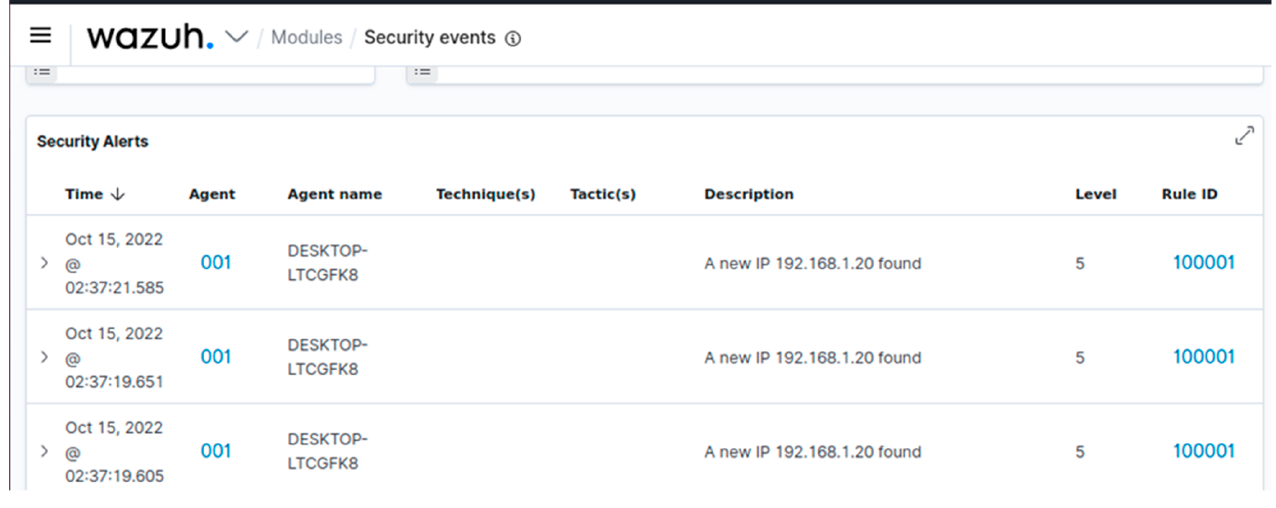
Figure 16. DoS A tt ack Alerts in Wazuh.